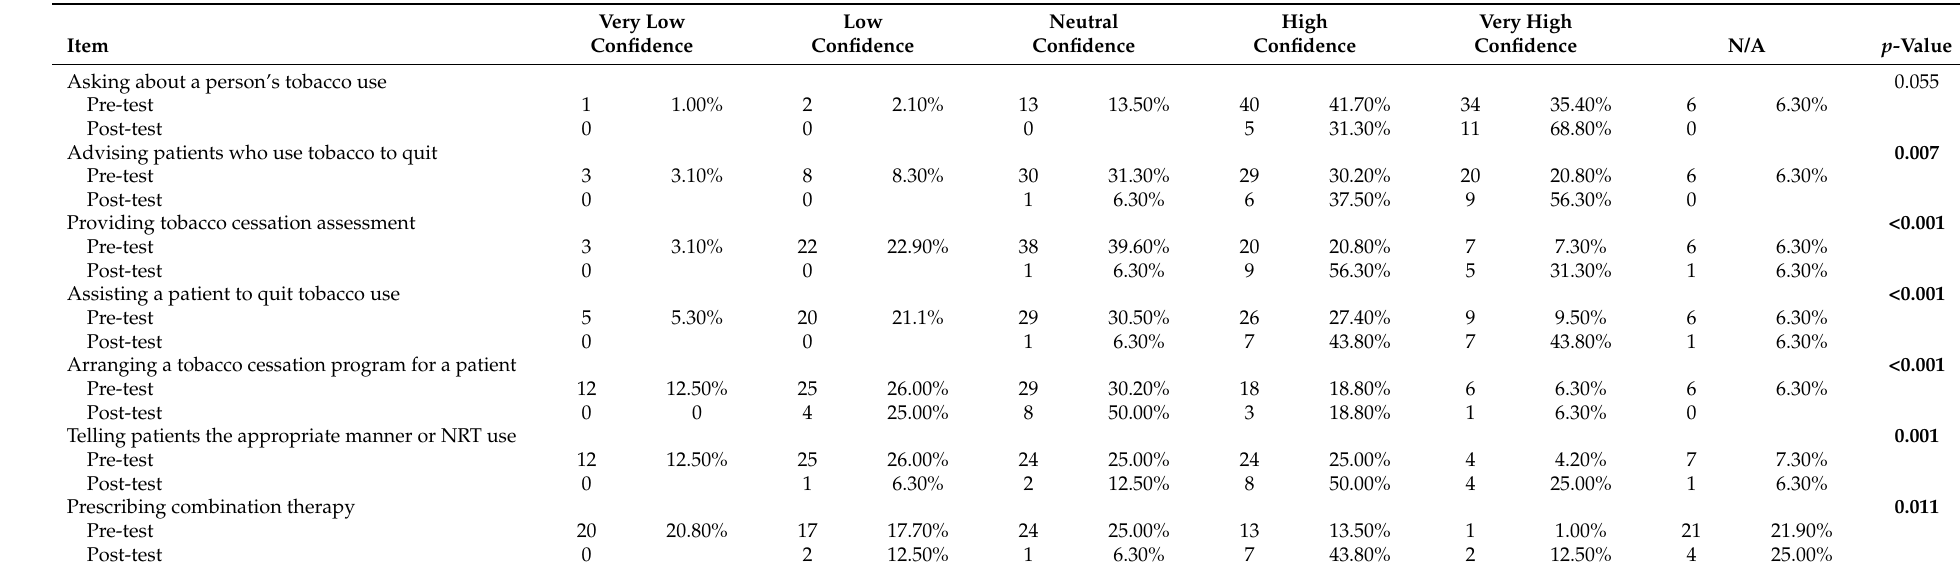
Table 2. Behavioral/outcome practices: Level of Confidence Gained between the Pre-test and